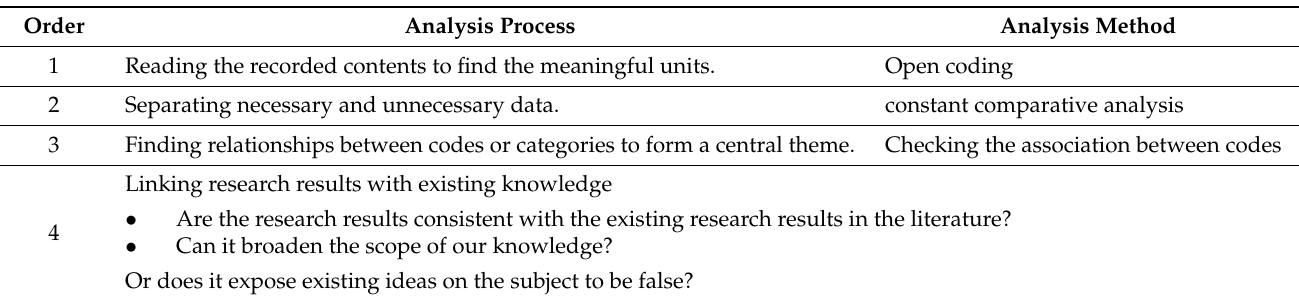
Table 2. The analysis procedure purposed by Padgett